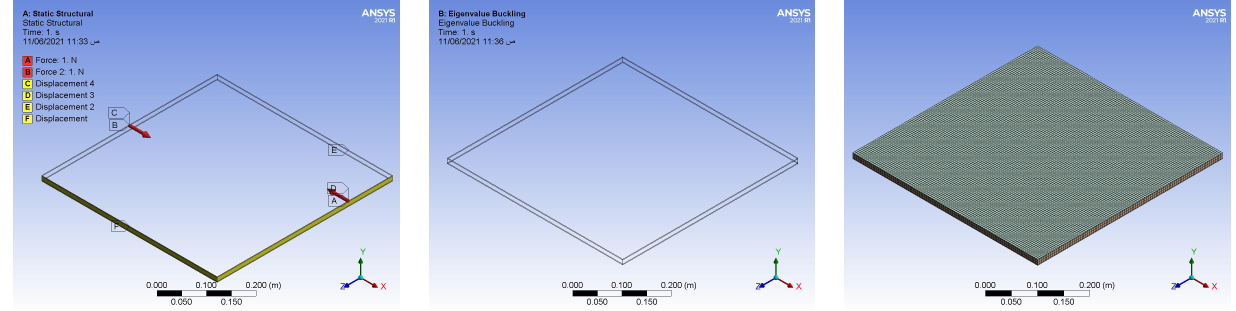
Fig. 3. FG sandwich plate model with mesh Table 2. Convergence of the critical buckling load